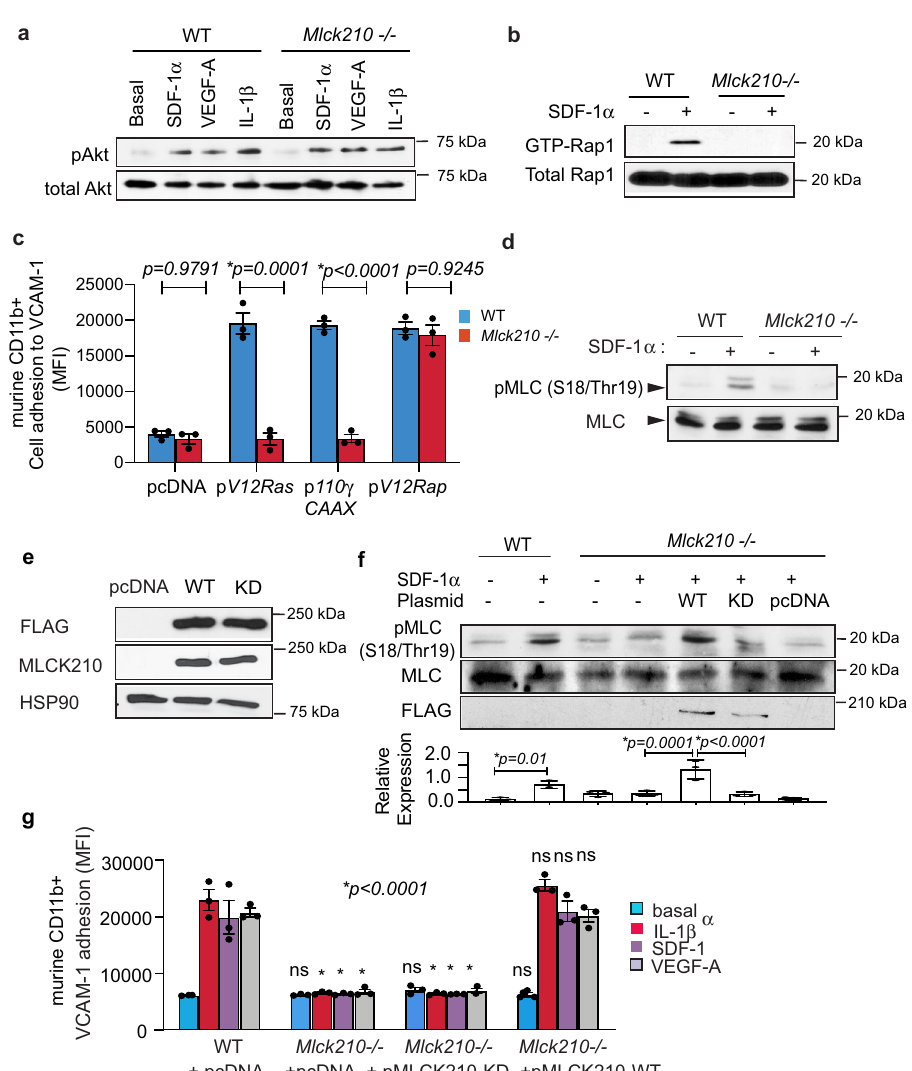
Fig. 4 PI3Kgamma activates MLCK210 and Rap-mediated adhesion. a Akt phosphorylation in WT and Mlck210 − / − cytokine-stimulated murine myeloid cells. b Rap1 GTP loading in cytokine-stimulated WT and Mlck210 − / − murine myeloid cells. c Adhesion to VCAM of WT and Mlck210 − / − murine myeloid cells ( n = 3) after transfection with active Ras ( G12VRas ), active PI3K γ ( p110 γ CAAX ), or active Rap ( RapG12V ). p = 0.9791 untransfected WT vs Mlck210 − / − , *p < 0.0001 G12VRas and p110 γ CAAX WT vs Mlck210 − / − , p = 0.9245 RapV12 WT vs Mlck210 − / − . Signi fi cance testing by unpaired t -test. d Myosin Light Chain (MLC) S18/Thr19 phosphorylation in basal or cytokine-stimulated WT and Mlck210 − / − murine myeloid cells. e Immunoblotting to detect Flag-tagged MLCK210, total MLCK210 and HSP90 in WT and Mlck210 − / − murine myeloid cells transfected with control (pcDNA) and MLCK210 expression plasmids. f Immunoblotting to detect phosphorylated MLC and total MLC in SDF1a stimulated or unstimulated WT or Mlck210 − / − myeloid cells that had been transfected with control (pcDNA) or fl ag-tagged WT and Kinase-dead (KD) MLCK210 expression plasmids. Graph: Relative pS18/Thr19-MLC expression in 3 independent samples. g Cytokine-stimulated VCAM-1 adhesion of WT and Mlck210 − / − myeloid cells transfected with control (pcDNA), WT or Kinase Dead (KD) MLCK210 expression constructs ( n = 3). *p = 0.0001 for cytokine-stimulated Mlck210 − / − cells and Mlck210 − / − cells expressing Mlck210 KD cDNA vs WT cells. No signi fi cant differences (ns) for WT vs Mlck210 − / − cells expressing Mlck210 WT cDNA, p = 0.9936 for IL1 β and p > 0.9999 for SDF-1a and VEGF-A treated cells. No signi fi cant differences (ns) for basal conditions ( p > 0.9999 ) . Signi fi cance determined by unpaired t -test for 4c and by one-way Anova with Tukey ’ s multiple comparisons for panels e , g . All replicates are biologically independent samples. Experiments were performed twice. Data are presented as mean values ± SEM. Source data are provided with this article as a Source Data fi content in tumors from Mlck210 − / − and WT BM transplanted DNA isolated from peripheral blood leukocytes (Fig. 7b). Tumor tumors. Using fl ow cytometry, we determined that the major growth, as measured by gross morphology, volume, and weight, effect of MLCK210 loss was on recruitment of Gr1lo bone- marrow-derived monocyte/macrophages to tumors (Fig. 7f, g; see Supplementary Fig. 6b for FACS gating strategy). Immuno fl uor- escence analysis of frozen tumors demonstrated that deletion of Mlck210 strongly reduced both macrophage and endothelial cell content in tumors, while increasing CD8 + T cell content in tumors (Fig. 7h, i). Tumors in mice bearing Mlck210 − / − bone